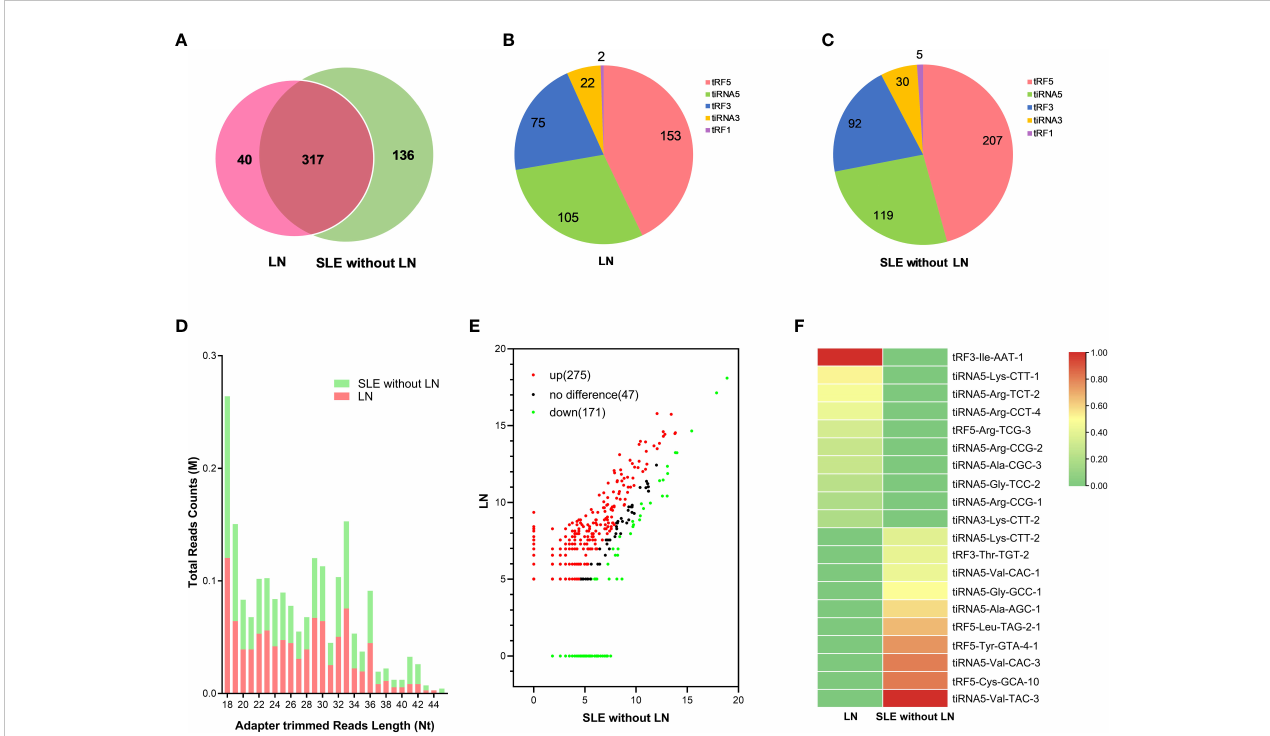
FIGURE 3 Analysis of differentially expressed tsRNAs in UEs of LN patients. (A) Venn diagram of urinary exosomes derived tsRNAs in LNs and SLE without LN patients. (B, C) The distribution of 5 types urinary exosomes derived tsRNAs in the two cohorts. (D) The pro fi les of various length of tsRNAs in urinary exosomes between the two cohorts. (E) Scatter plots of differentially expressed tsRNAs. Red and green dots indicated upregulated and downregulated tsRNAs (log2 fold-change > 1.5 between the two compared cohorts), and black dots indicated non-differentially expressed tsRNAs. (F) Hierarchical clustering indicated the pro fi les of top 10 upregulated and downregulated tsRNAs between two cohorts.